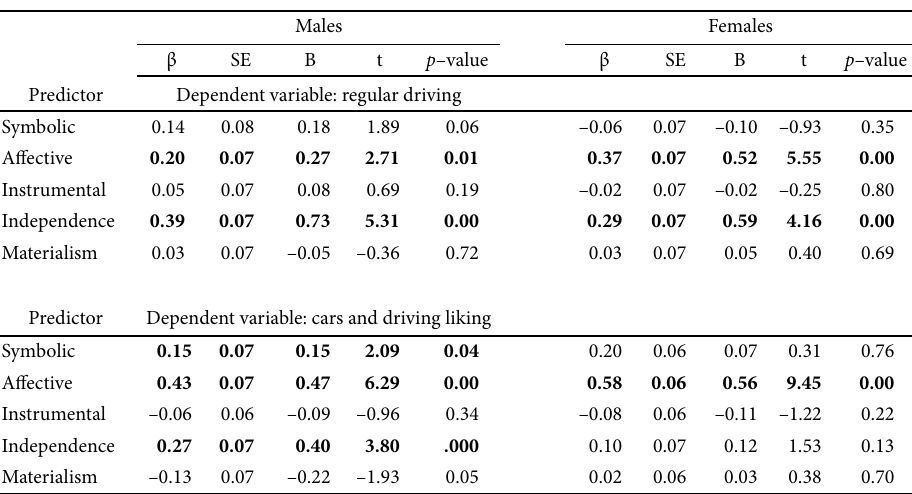
Instrumental Independence Materialism 0.70 Note : The bold font indicates significance at p <